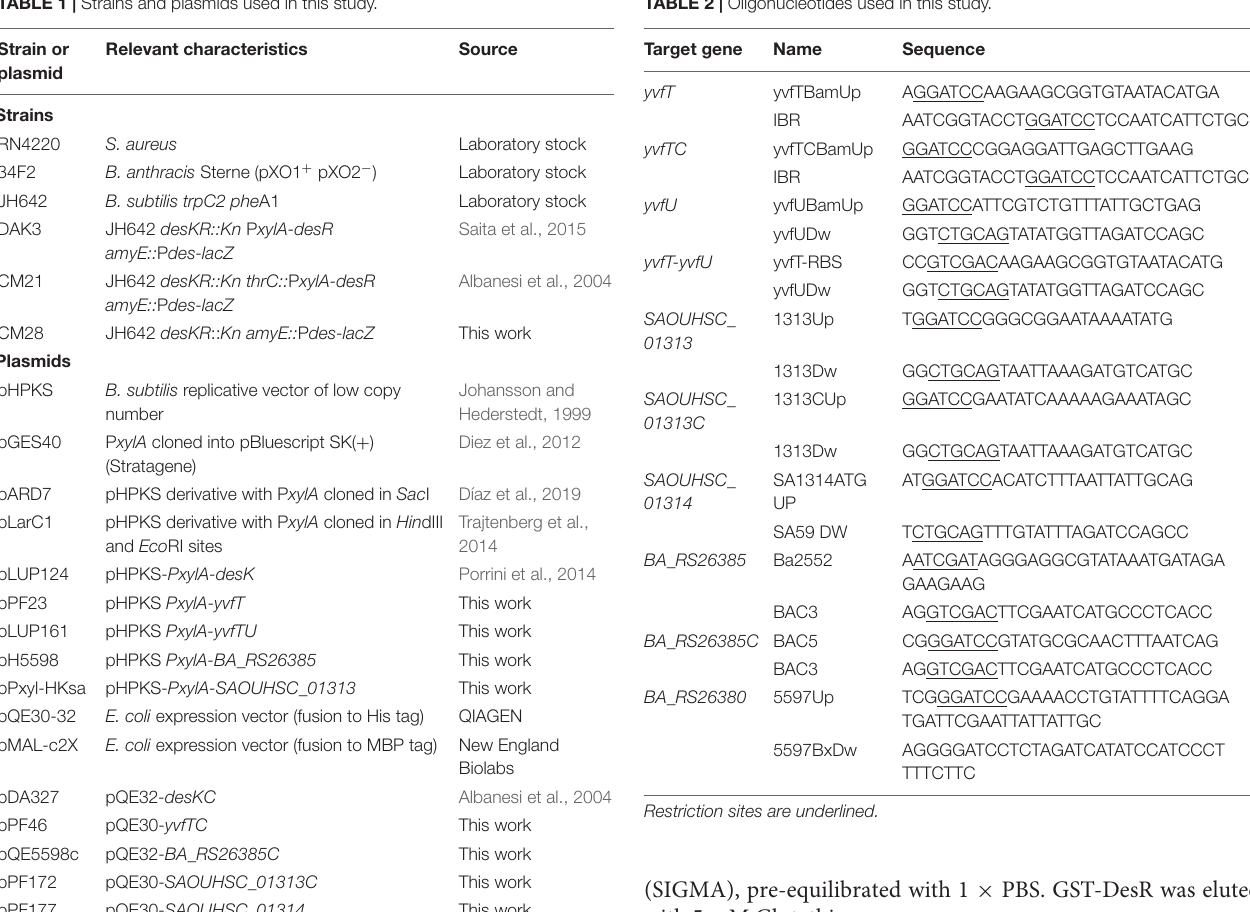
TABLE 1 | Strains and plasmids used in this study. TABLE 2 | Oligonucleotides used in this